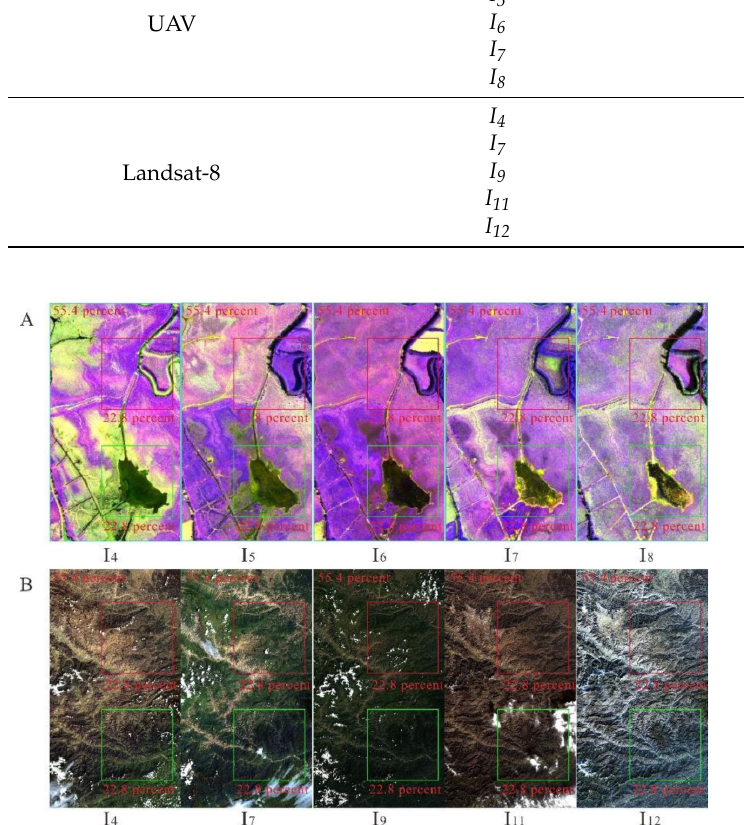
Figure 4. Distribution of training, testing, and validation samples in first set of experiment: ( A ) un- manned aerial vehicle (UAV) and ( B ) Landsat-8 images; areas inside red and green box and remainder of images show distribution of training, testing, and validation samples,